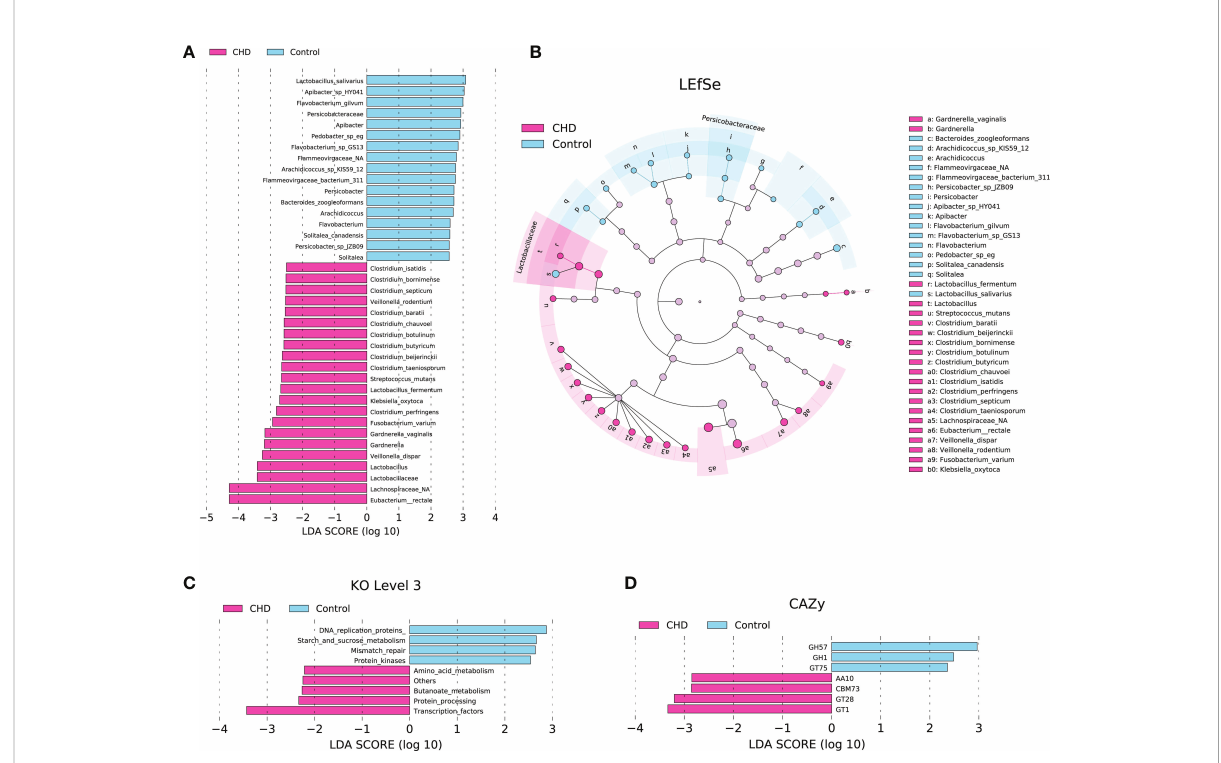
FIGURE 4 Differential taxa, KOs, and CAZymes between CHD and control groups identi fi ed by linear discriminant analysis (LDA) effect size (LEfSe) with default parameters (p-value < 0.05 and LDA scores > 2.0). (A) Differential taxa identi fi ed by LDA score. (B) Cladogram of differential taxa between CHD and control groups. (C) Differential KOs at level 3 identi fi ed by LEfSe. (D) Differential CAZymes identi fi ed by